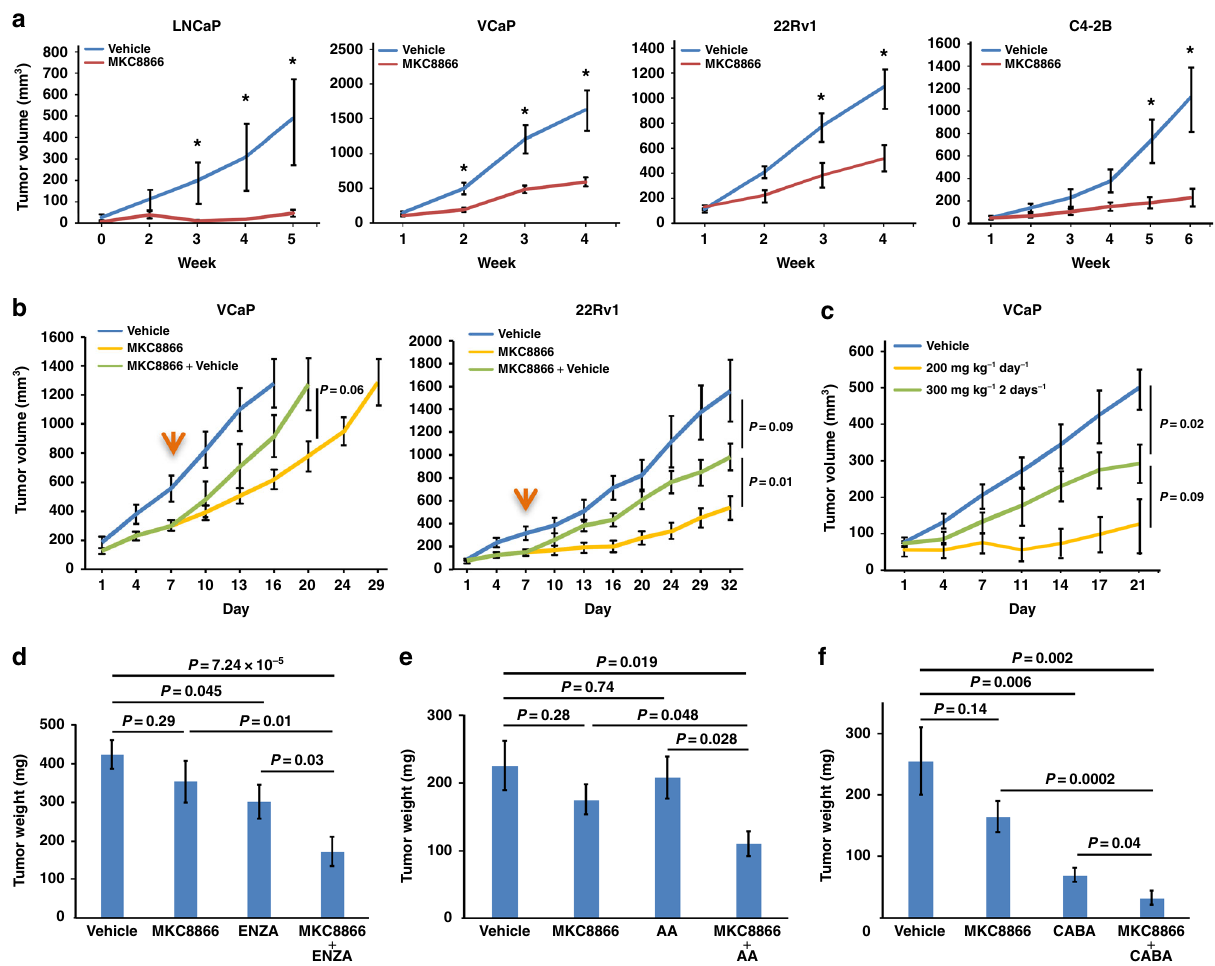
Fig. 2 Therapeutic ef fi cacy of MKC8866 in preclinical mouse models of PCa. a Nude mice bearing LNCaP, VCaP, 22Rv1, or C4-2B xenografts were treated orally with either vehicle or 300 mg kg − 1 MKC8866 daily and tumor growth was recorded. b Nude mice bearing VCaP or 22Rv1 tumors were treated with either vehicle or 300 mg kg − 1 MKC8866 daily. At day 7 (indicated by the orange arrow), the MKC8866-treated mice were randomly divided into two groups, one of which continuously received MKC8866 of the same dosage while the other group was treated with vehicle for the rest of the experiment. c Nude mice bearing VCaP xenografts were orally treated with either vehicle, 200 mg kg − 1 MKC8866 daily, or 300 mg kg − 1 MKC8866 every other day. Tumor growth was recorded weekly. d Nude mice bearing VCaP xenografts were orally treated either with vehicle, MKC8866 (300 mg kg − 1 every two days), enzalutamide (ENZA, 30 mg kg − 1 every two days), or MKC8866 + ENZA. Tumor weight was recorded at the end of the experiment. e As in d , but the treatments were vehicle, MKC8866 (300 mg kg − 1 every two days), abiraterone acetate (AA, 20 mg kg − 1 every two days), or a combination of both drugs. f As in d , but the treatments were vehicle, or MKC8866 (300 mg kg − 1 every two days), or cabazitaxel (CABA, 5 mg kg − 1 ) twice a week intraperitoneally, or a combination of both drugs. * P < 0.05, all P values were calculated by Student ’ s t -test, error bars denote the